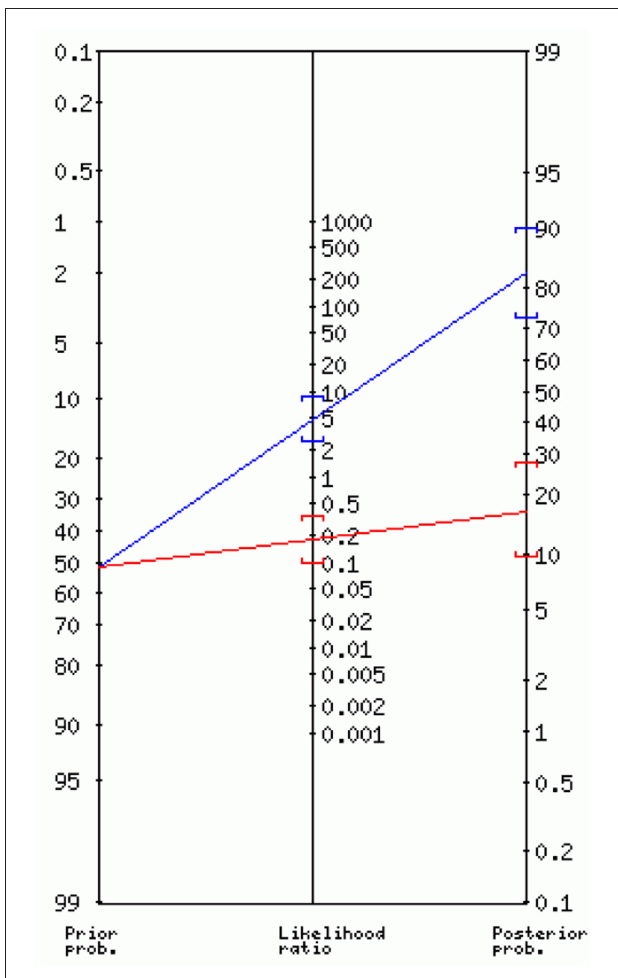
FIGURE 3 | Interpreting the diagnostic utility of the best-performing classifier using Bayes’